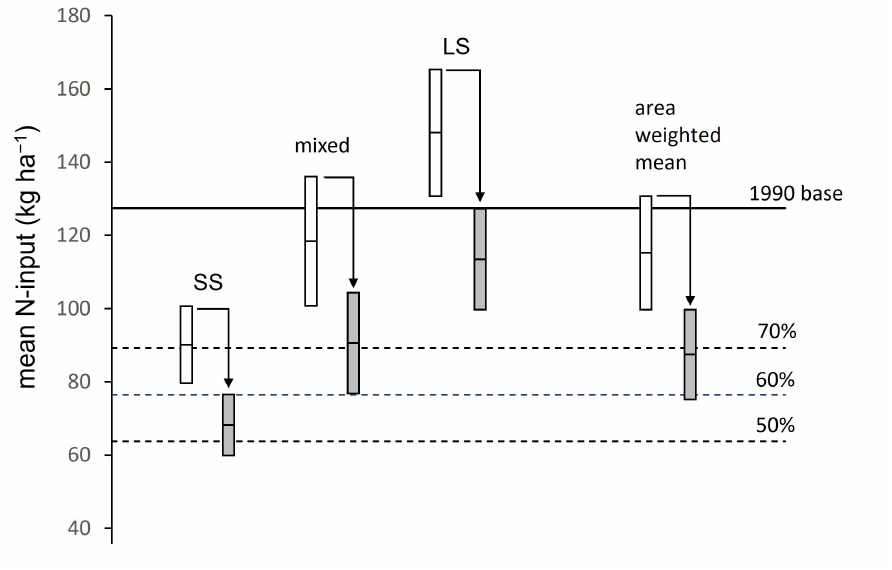
Figure 6. Estimated nitrogen fertiliser input to short-season (SS, spring sown), long season (LS, autumn sown) and mixed cereal systems: open bars are for current inputs (2012–2016, based on fertiliser survey) and shaded bars for reduced input comparable to the CSC-integrated treatment; length of bar indicates range from no grain legume (upper), 10% grain legume (mid) and 20% grain legume (lower); the all-arable 1990 base and reduction targets are shown by horizontal